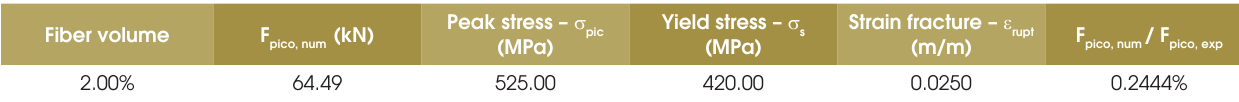
Table 10 – Model parameters for homogenization of La Borderier [4]